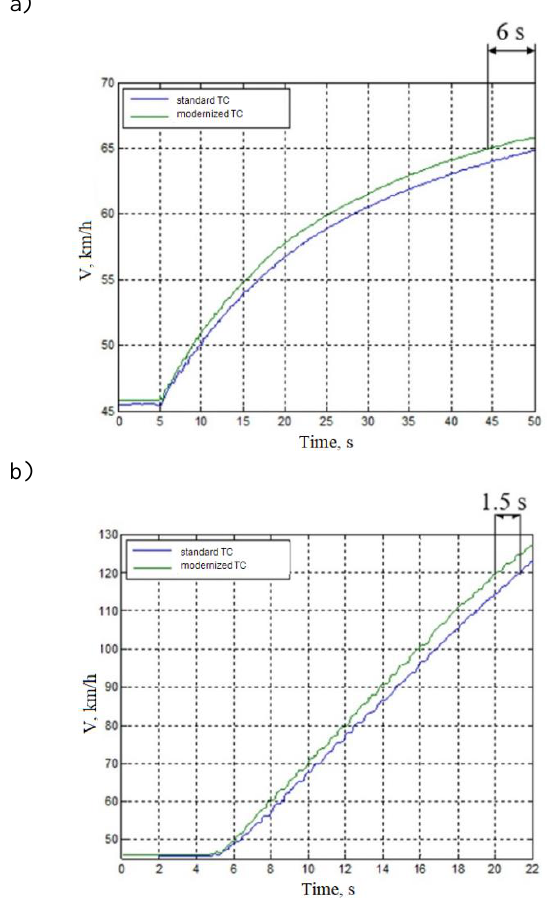
Fig. 8. Comparison of the driving forces during acceleration with and without the supercharger system for different throttle positions: a) 20%,